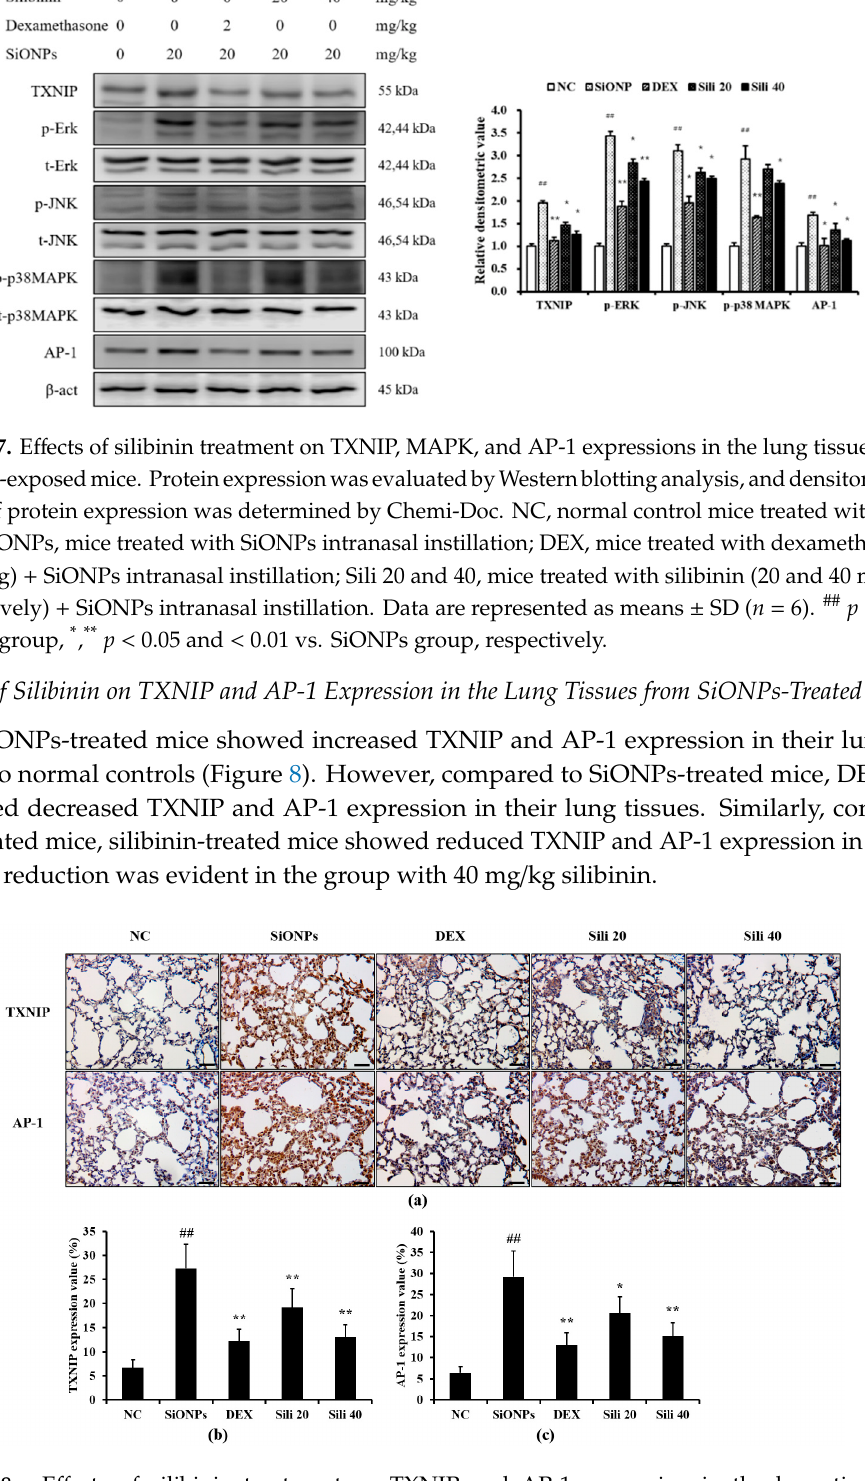
7 of 12 Figure 6. Effects of silibinin treatment on pulmonary inflammation caused by SiONPs exposure. A representative figure in the lung tissue stained with hematoxylin and eosin (×200). Quantitative analysis of inflammatory response was determined by an image analyzer. Scale bars indicate 50 μ m. NC, normal control mice treated with PBS only; SiONPs, mice treated with SiONPs intranasal instillation; DEX, mice treated with dexamethasone (2 mg/kg) + SiONPs intranasal instillation; Sili 20 and 40, mice treated with silibinin (20 and 40 mg/kg, respectively) + SiONPs intranasal instillation. Data are represented as means ± SD ( n = 6). ## p < 0.01 vs. NC group, * , ** p < 0.05 and < 0.01 vs. SiONPs group, respectively. 3.6. Effects of Silibinin on the Expression of TXNIP, MAPKs, and AP-1 in SiONPs-Treated Mice SiONPs-treated mice showed a marked elevation of TXNIP expression compared to the NC mice